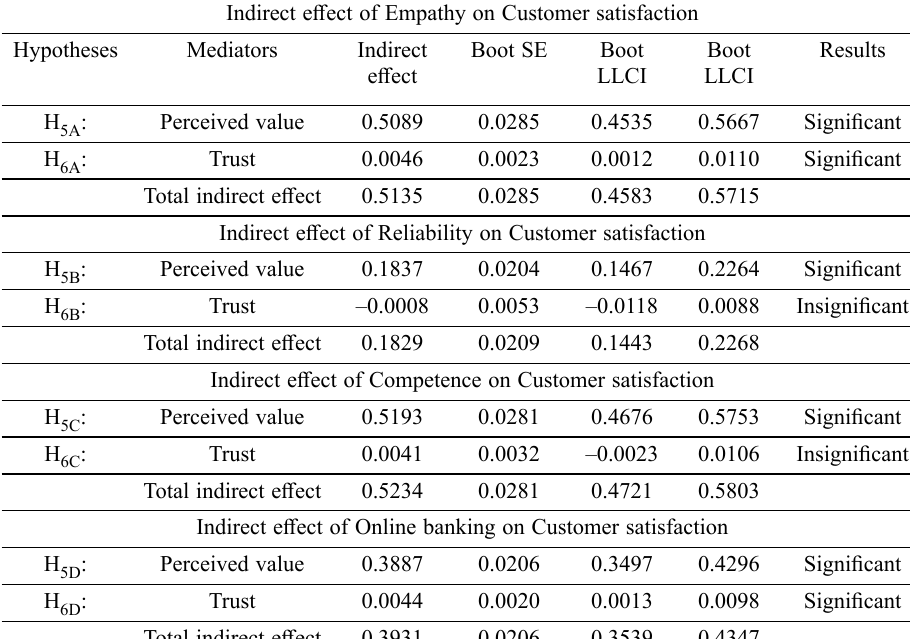
Table 7. Mediating effects (bootstrapping method) Indirect effect of Empathy on Customer